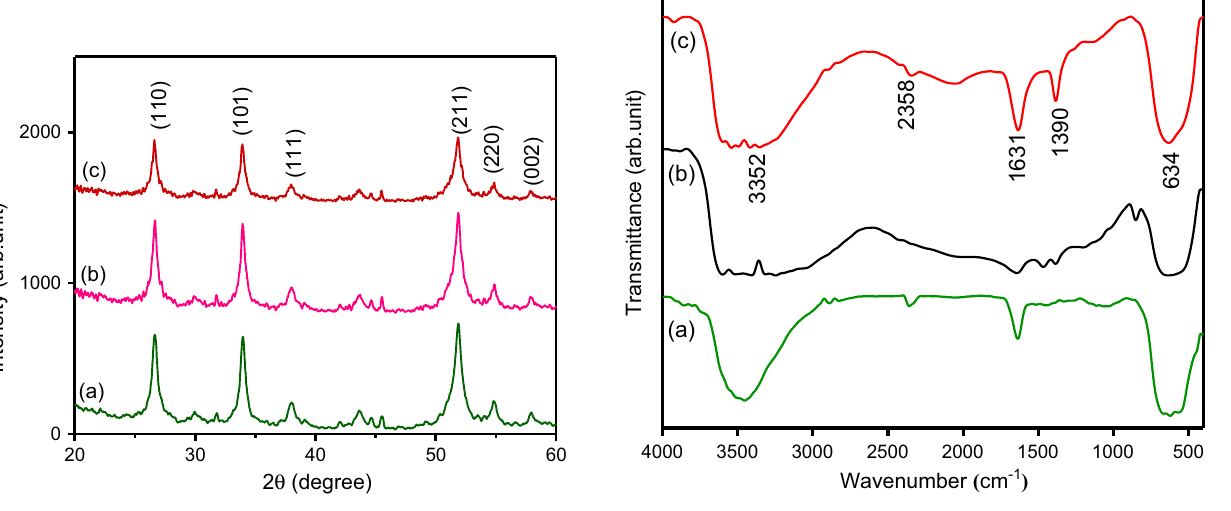
2 , (b) 2% Zr-doped SnO 2 NPs and (c)